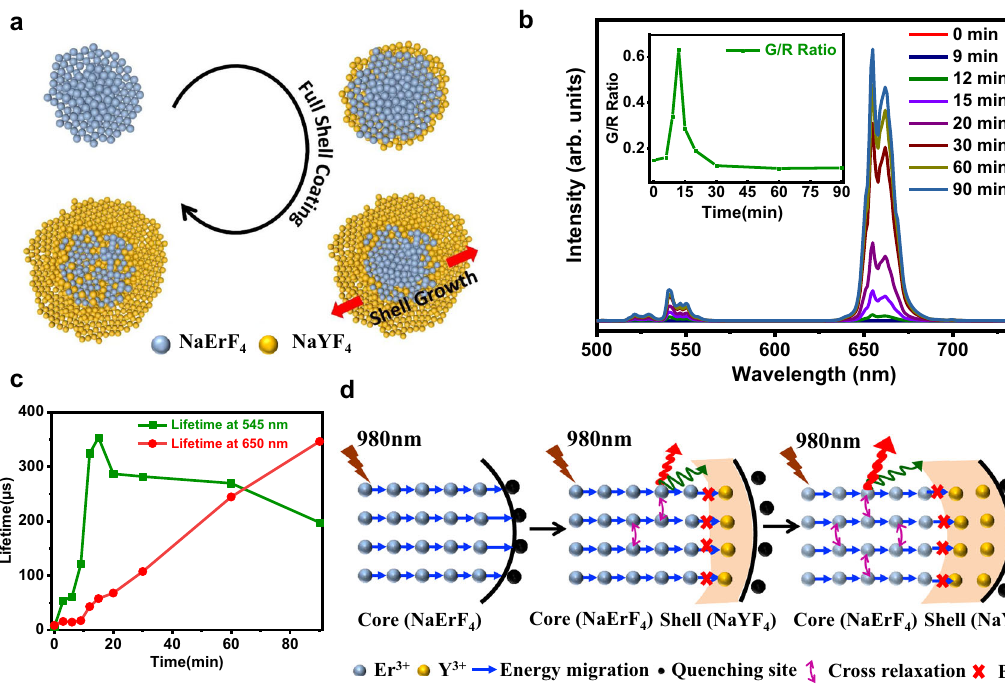
Fig. 2 Time-course study on the growth of core-shell NaErF 4 @NaYF 4 UCNPs. a Schematic of the growing process of full NaYF 4 shell (yellow) on the NaErF 4 core (blue). During the full shell coating process, the NaYF 4 shell would grow along both sides (red arrow) of the luminescent NaErF 4 core. b The changes of upconversion emission spectra under 980 nm laser light (3 W cm − 2 ) over time. Inset is the variations of green to red ratio over time. c The lifetime of red and green emissions over time. d The mechanism of the surface protection of NaErF 4 core by NaYF 4 shell with different thickness. Upon excitation by 980 nm light, the excitation energy is rapidly transferred to the surface quenchers for bare NaErF 4 core. When a thin NaYF 4 shell (shaded region) is coated, the surface defects are partly restored that preferentially promotes the green emission. As the thickness of NaYF 4 shell goes up, the energy loss from Er 3 + ions to surface defects is further blocked and the possibility of cross relaxation between Er 3 + ions is greatly raised, which dramatically enhances the red